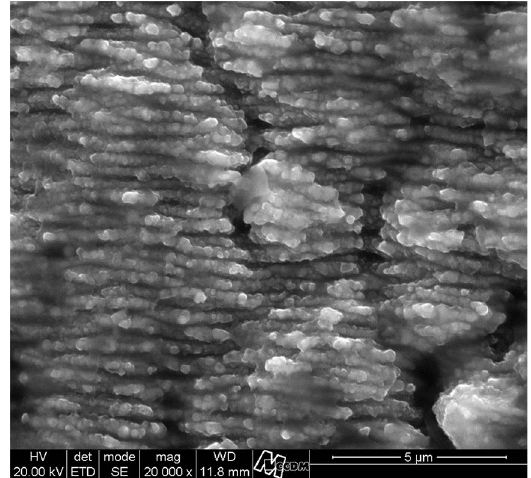
Figure 4. SEM micrograph of LIPSS covering all micro-columns.